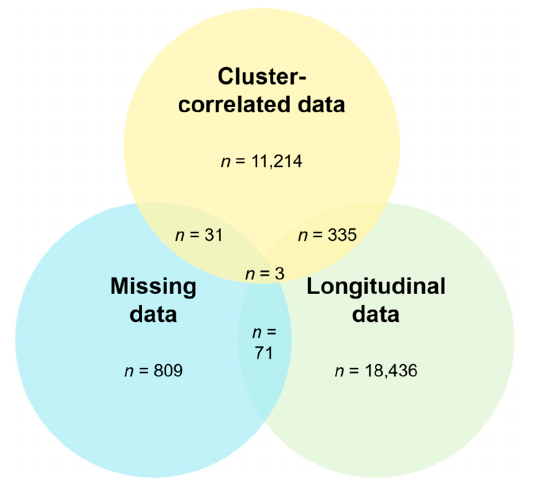
Figure A1. Results of the step-by-step search strategy using PubMed.